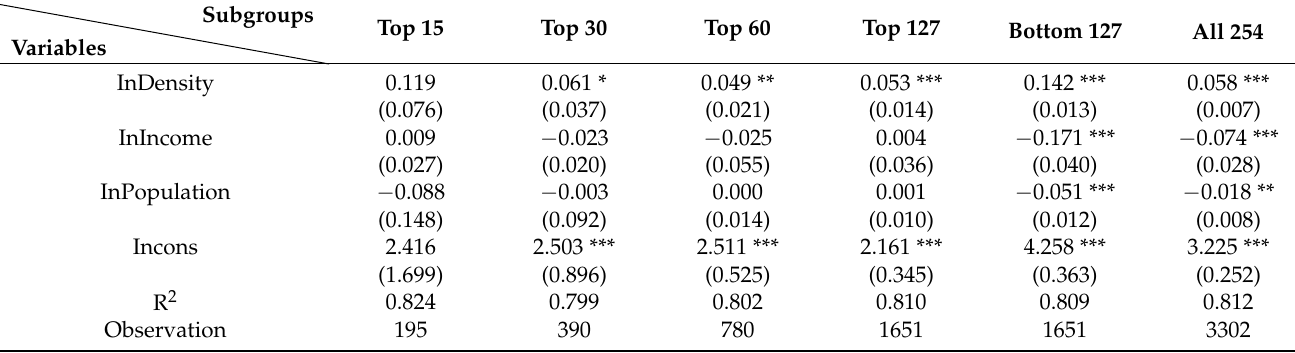
Table 5. Multivariate panel analysis of PM 2.5 concentrations for six density subgroups